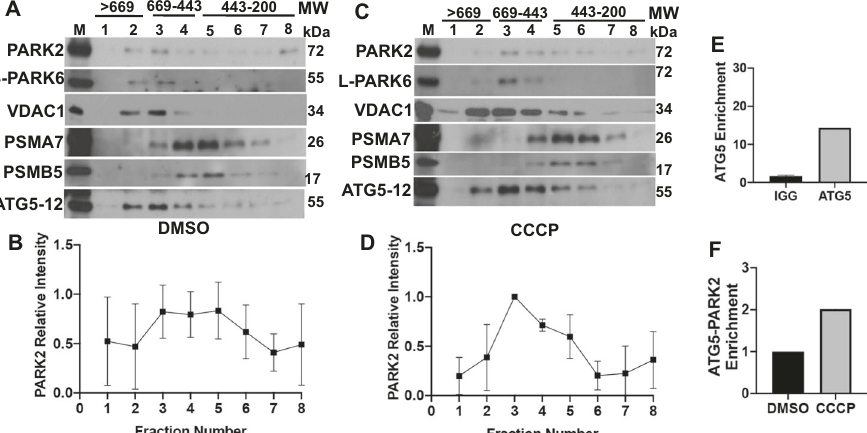
Fig. 3 Identi fi cation of novel protein complexes that assemble under basal or mitochondrial stress conditions. A and C , Western blot images representing the levels of PARK2, PARK6, VDAC1, PSMA7, PSMB5 and ATG5-12 following gel fi ltration chromatography performed using mitochondrial lysates collected from YFP-PARK2 expressing HEK 293 T cells treated with either DMSO ( A ) , or CCCP ( C) for 12 h. M, mitochondrial extracts before fractionation. L-PARK6, uncleaved/unprocessed form of PARK6 (63 kDa). S-PARK6, cleaved/processed form of PARK6 (55 kDa). B and D , Quanti fi cations of PARK2 relative intensity in A and C respectively ( n = 3). E and F , Graphs showing SILAC-MS/MS enrichments of ATG5 ( E ) and PARK2-ATG5 complex ( F ) in mitochondrial fraction ( n =